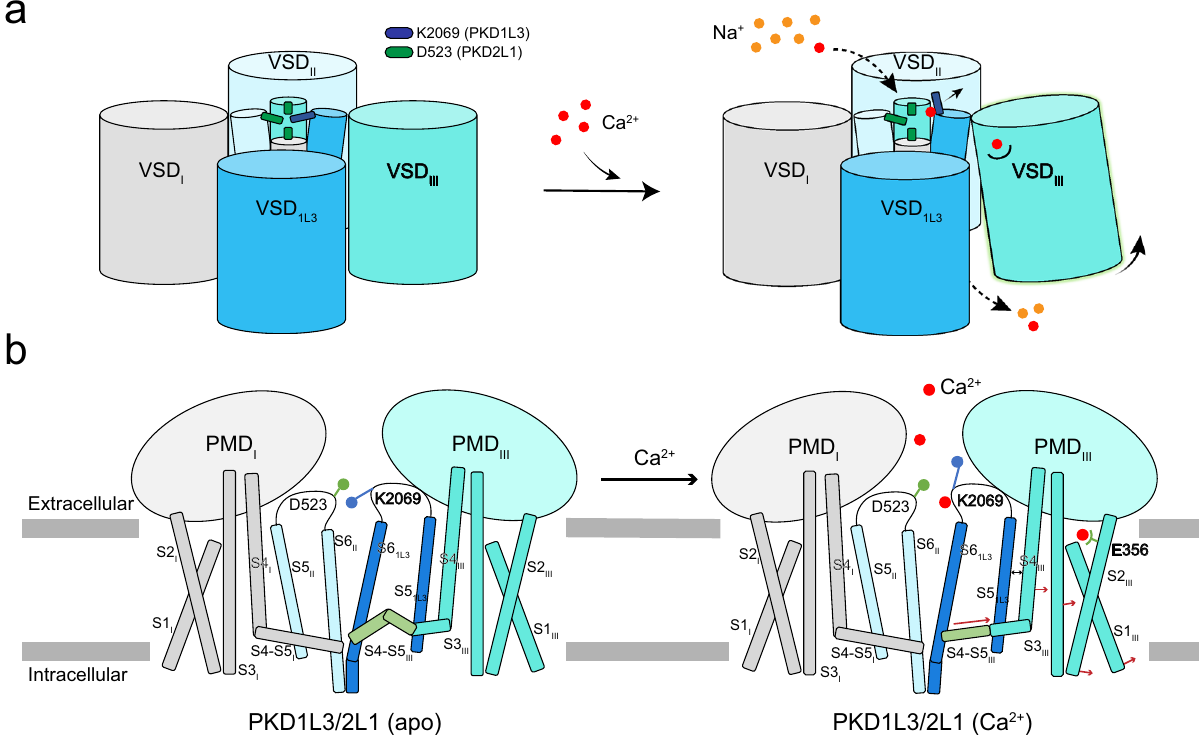
Fig. 5 A working model for Ca 2 + activation of PKD1L3-CTD/2L1. a An overall schematic illustration of the conformational changes of the heterochannel upon Ca 2 + binding to the SF and VSD III . The Ca 2 + and Na + ions are shown as red and orange circles, respectively. b A more detailed illustration of the change of channel segments corresponding to the two states shown above. Two diagonal views are